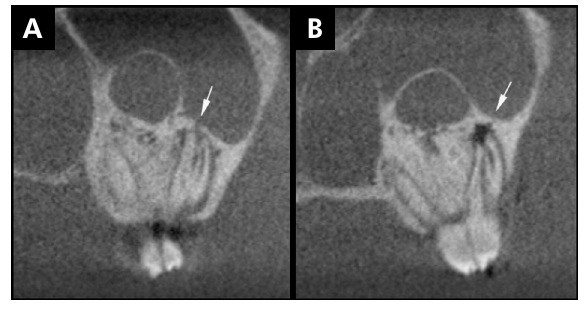
Figure 2. Coronal CBCT images: A) Sample with oroantral com- munication (arrow) caused by periapical lesion; B) Sample without disruption of cortical sinus (arrow) close to periapical lesion.